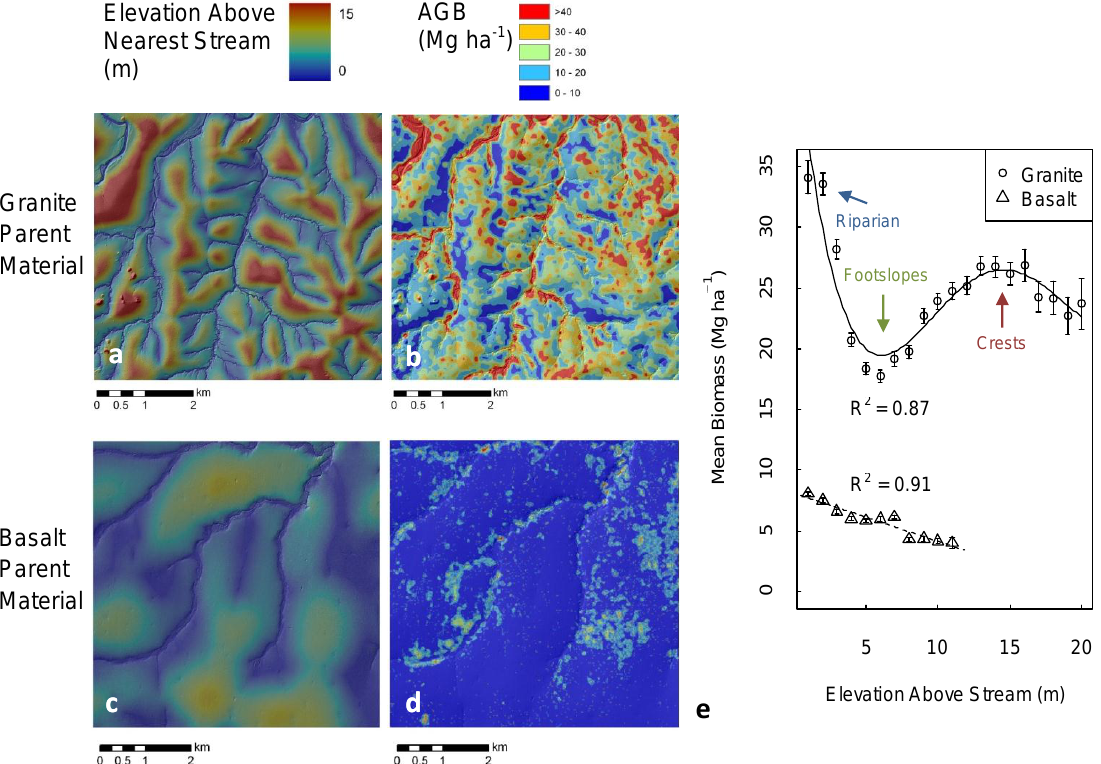
Fig. 3. Spatially explicit correlation of elevation above nearest stream (a, c) ) to LiDAR-estimated AGB (b, d) ) for granite (Skukuza, top row) and basalt (Lower Sabie, bottom row). Each point in the graph (e) represents the mean of all biomass pixel values (0.07ha resolution) within a one meter bin of elevation for the extents shown in (b, d) . Error bars are 2 × standard error of the mean. Note increase in AGB on granitic crests above the seepline ( ∼ 7m), whereas mean AGB on basalts exhibits a linear decrease in AGB for all elevation gain above nearest stream. Solid curve is the granite, best-fit polynomial model of (fourth order) with R 2 =0.87 and dashed line is the substrate best-fit model ( R 2 =0.91). Note the basalt error bars are drawn but are smaller than the point